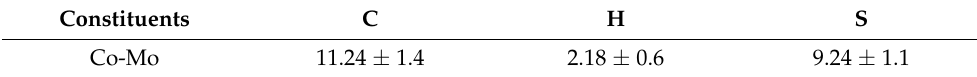
Table 2. The concentration of C, H, and S in the spent unroasted catalysts (%wt). Constituents C